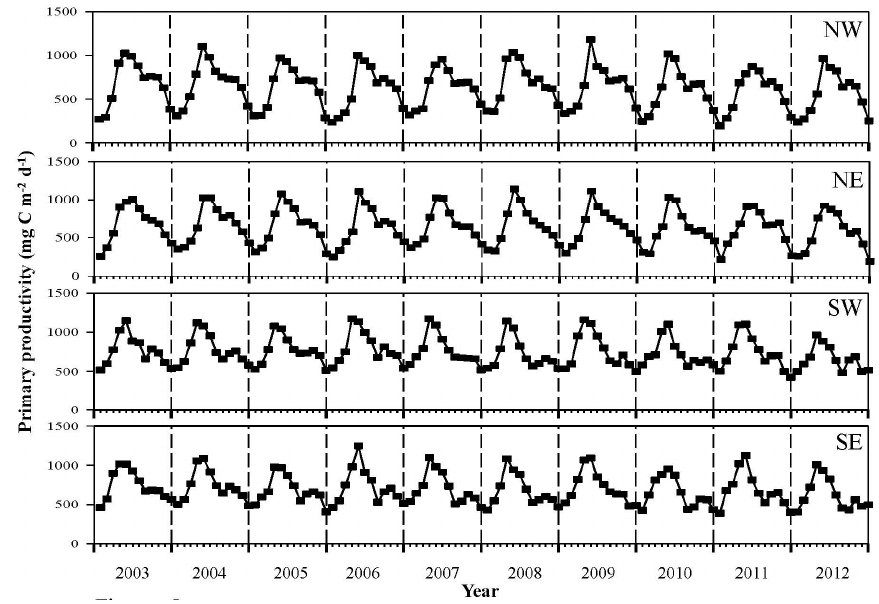
Figure 5. Time series of monthly variability in primary productivity for the four sub-research areas in the East Sea from January 2003 to December